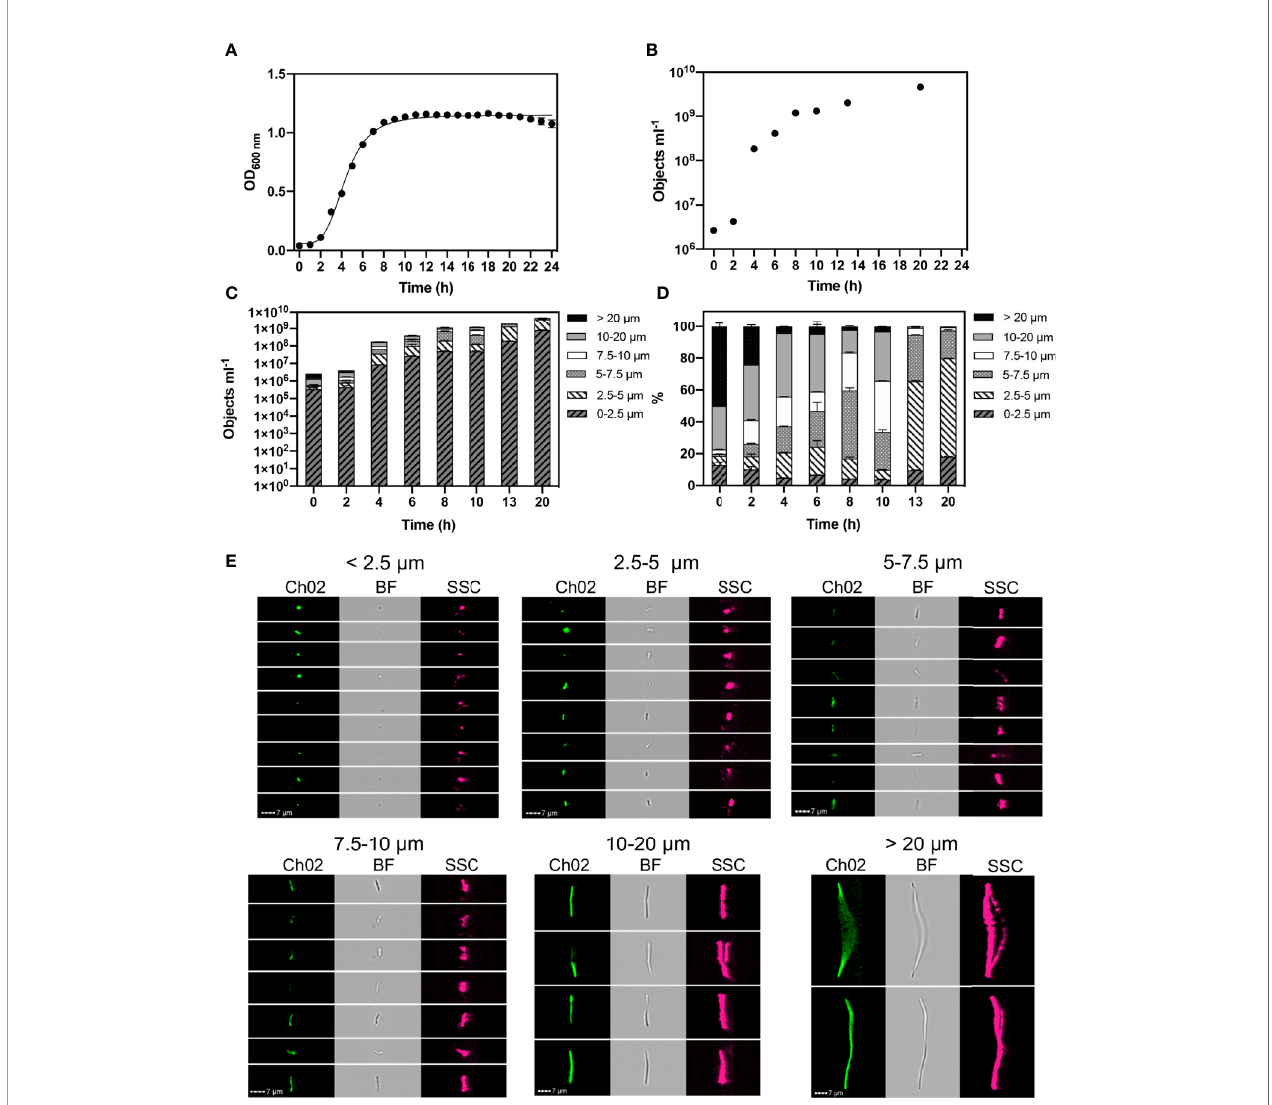
FIGURE 1 | Monitored phenotypes of Bacillus subtilis WB800N during 24 h growth. Hourly optical density (OD 600 ) measurements were performed (A) . Imaging Flow Cytometry was used to determine: cell concentration (objects ml -1 ) (B) . Concentrations of different cell morphologies (as indicated by cell length) (C) and their relative proportions (D) are presented at selected time points. Exemplar cell images of auto fl uorescence (Ch02: 533/55 nm), bright fi eld (BF: 610/30 nm) and side scatter (SSC: 762/35 nm) within selected cell length intervals are shown (E) . n= 3 ; error bars represent standard error of the